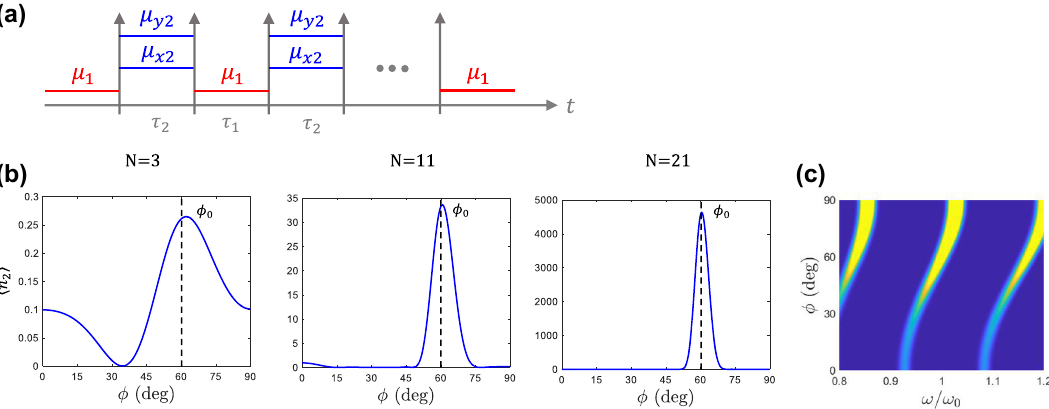
Figure 6: Vacuum amplification concentrated on a single direction. (a) Sketch of a N -layered temporal boundary sequence constructed by = 𝜀 = 1) isotropic temporal slabs 𝝁 = 𝜇 ( ̂ x ̂ x + ̂ y ̂ y ) of duration 𝜏 , and anisotropic temporal the concatenation of unit-permittivity ( 𝜀 1 1 1 z 1 z 2 ̂ x ̂ x + 𝜇 ̂ y ̂ y of duration 𝜏 = 𝜇 . (b) Photon production from a mode with wavenumber k as a function of the observation angle 𝜙 slabs 𝝁 2 x 2 y 2 2 = 1, 𝜇 = 2 and 𝜇 = 3, 𝜏 = ( 𝜋 ∕ 2) ∕ ( kc ) and 𝜏 = (5 𝜋 + 𝜋 ∕ 2) ∕ 𝜔 for temporal sequences of N = 3, N = 11 and N = 21 layers, with 𝜇 ( 𝜙 ), 1 2 x 2 y 1 2 0 k 2 = 60 deg. The results show that the photon production exponentially grows with the number of temporal layers, while being with 𝜙 0 direction. (c) Colormap of the photon production as a function of observation angle 𝜙 and frequency 𝜔 ′ ∕ 𝜔 , with concentrated along the 𝜙 0 0 𝜔 ′ = k ′ c and 𝜔 = kc , showing that the peak angle periodically shifts with frequency scanning all directions. 0